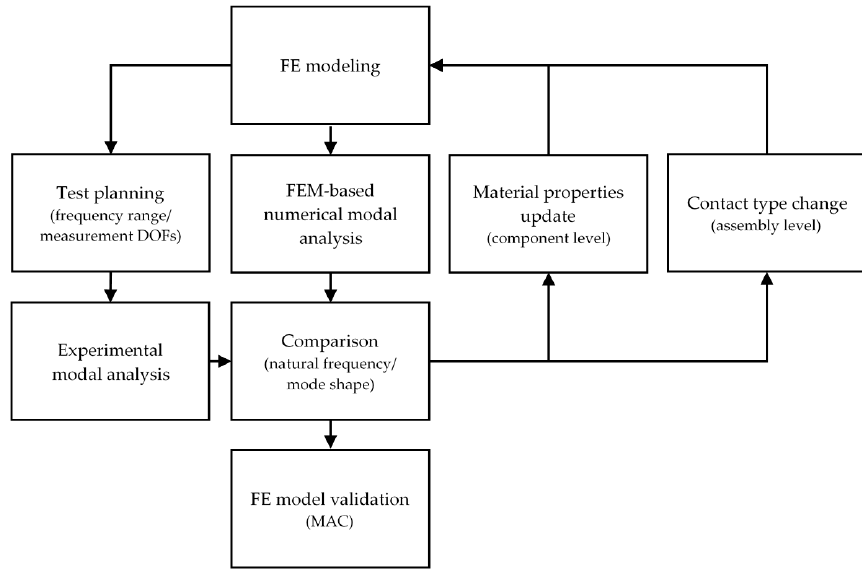
Figure 1. Flowchart for the finite element (FE) model update process.